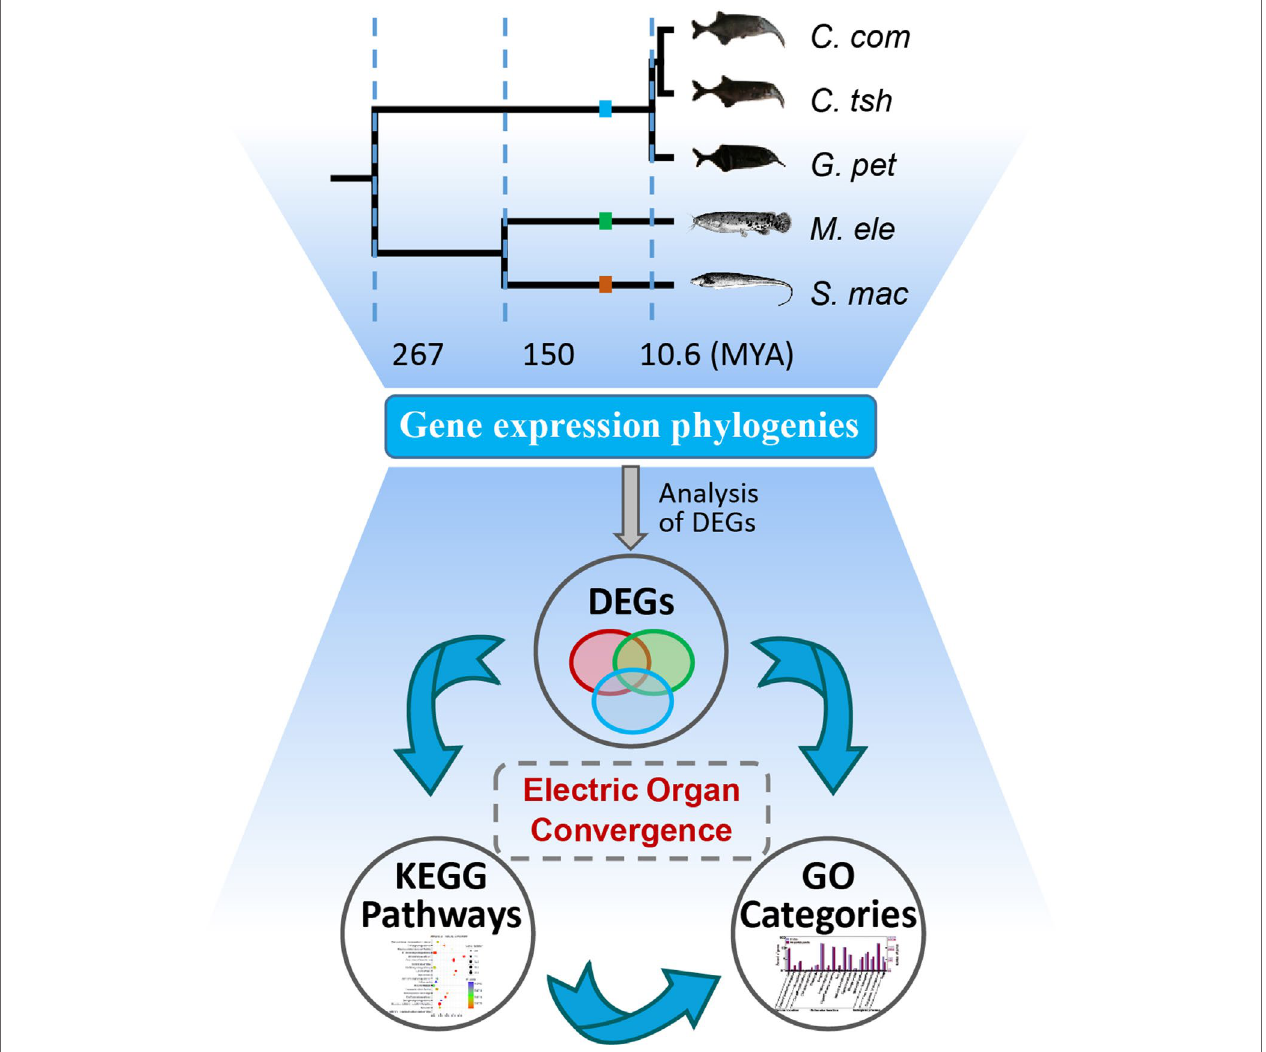
FIGURE 1 | Analysis of genetic mechanism underlying phenotypic convergence of electric organs among electric fishes. The species tree was obtained from previous studies (Lavoue et al., 2012; Gallant et al., 2014; Lamanna et al., 2015) and the TimeTree database (Hedges et al., 2015). Fish images obtained from Lamanna et al. (2015) or FishBase (https://www.fishbase.se/home.htm). EO and SM represent the electric organ and skeletal muscle, respectively. C. com , C. tsh , G. pet , M. ele , and S. mac represent C. compressirostris , C. tshokwe , G. petersii , M. electricus , and S. macrurus , respectively. We used these same abbreviations for all the following figures and